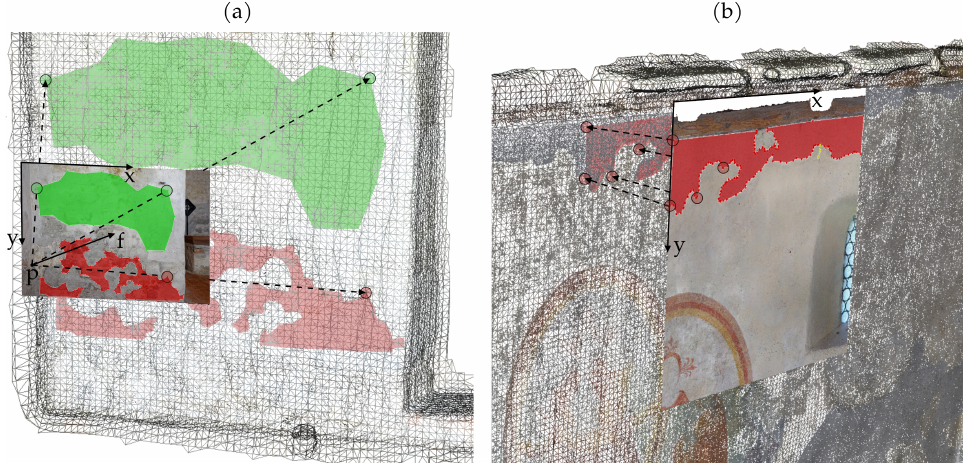
Figure 5. Exemplary mappings of 2D annotations of missing plaster (red) and craqueles (green) from the case study dataset on the triangle mesh surface; ( a ) an image-based central projection showing the estimated position of the camera p , the focal length f as a vector to the image centre, and the orientation of the local coordinate system and ( b ) an orthogonal projection from an orthophoto patch, which was registered to the 3D